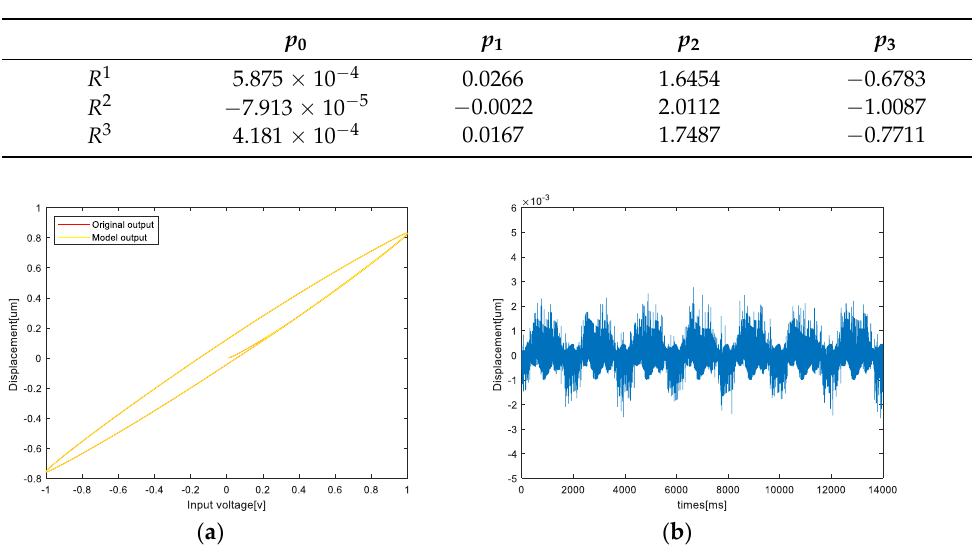
Table 1. Identification parameters of the T-S fuzzy model.